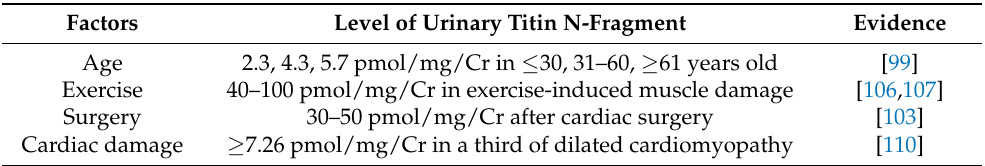
Table 1. Factors leading to an increase in the urinary titin